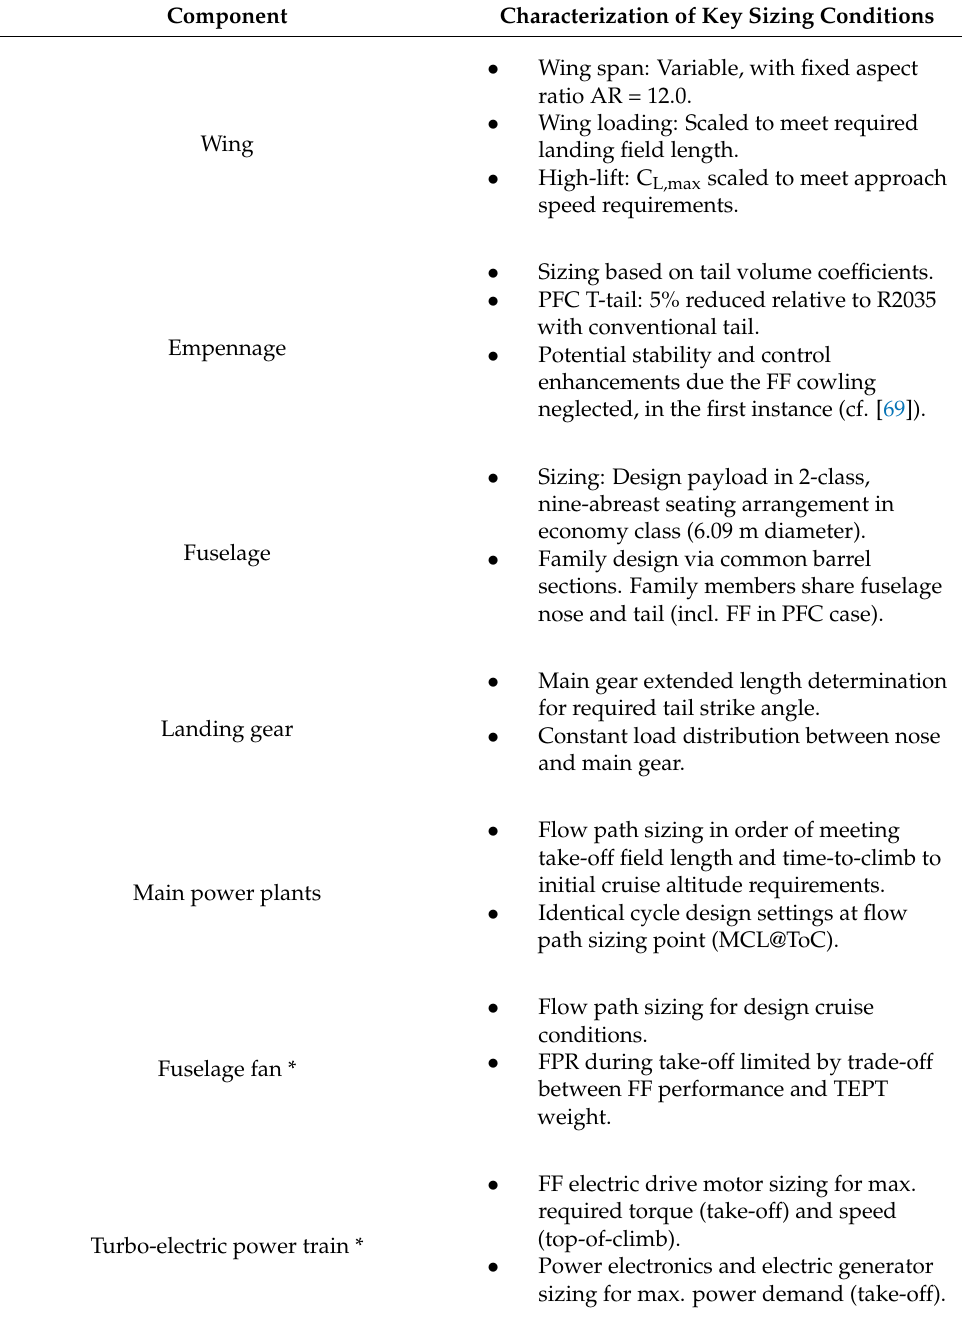
Table 12. Overview of specific component sizing laws for the R2035 and PFC aircraft